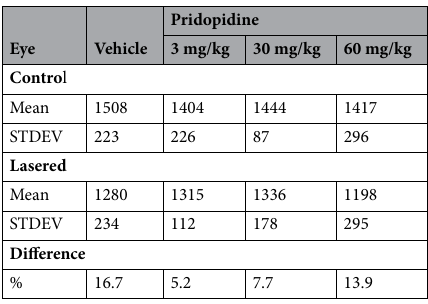
Table 2. The number of RGCs per retinal area of lasered eyes in different treatment groups with 125/55 exclusion criteria.